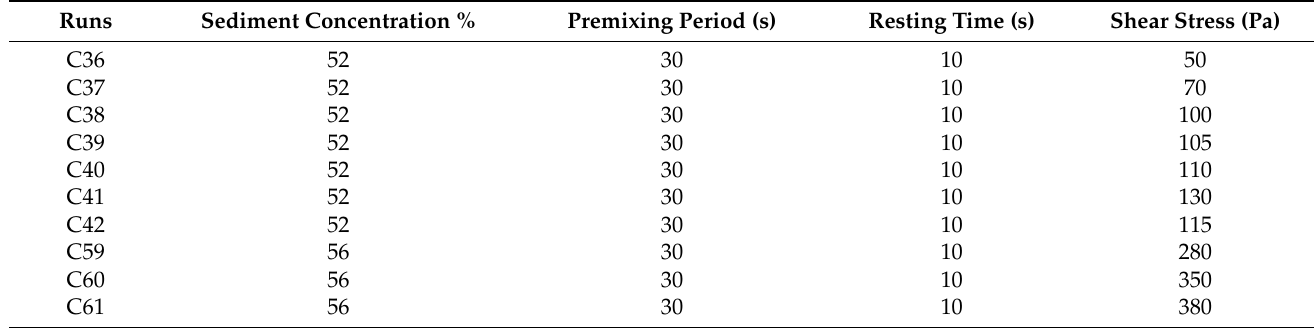
Table 2. Creep tests